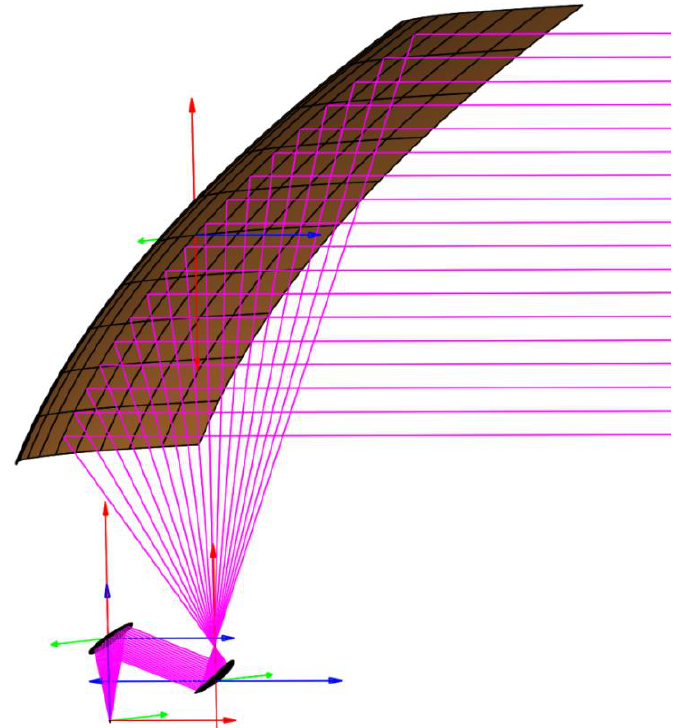
Figure 3. The simulated model of designed tri-reflector compact antenna test range (CATR) with standard quadric surfaces in GRASP-10 software.